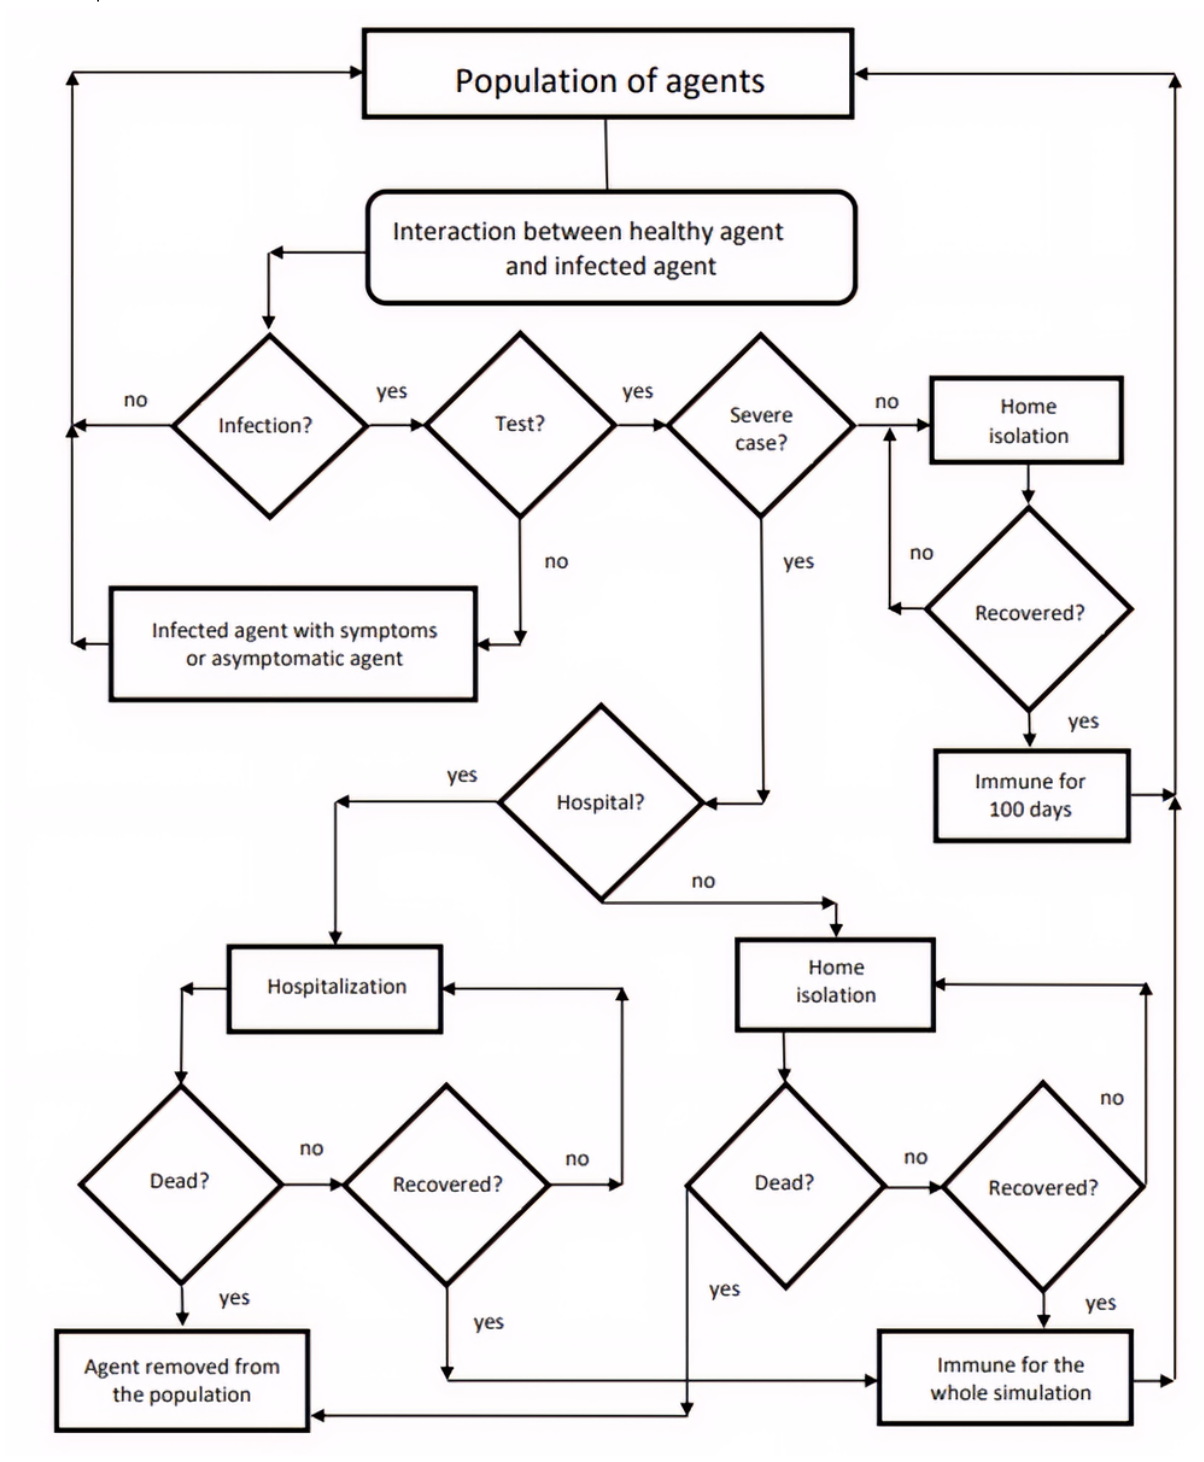
Figure 1. Simplified flowchart of interaction mechanisms in the